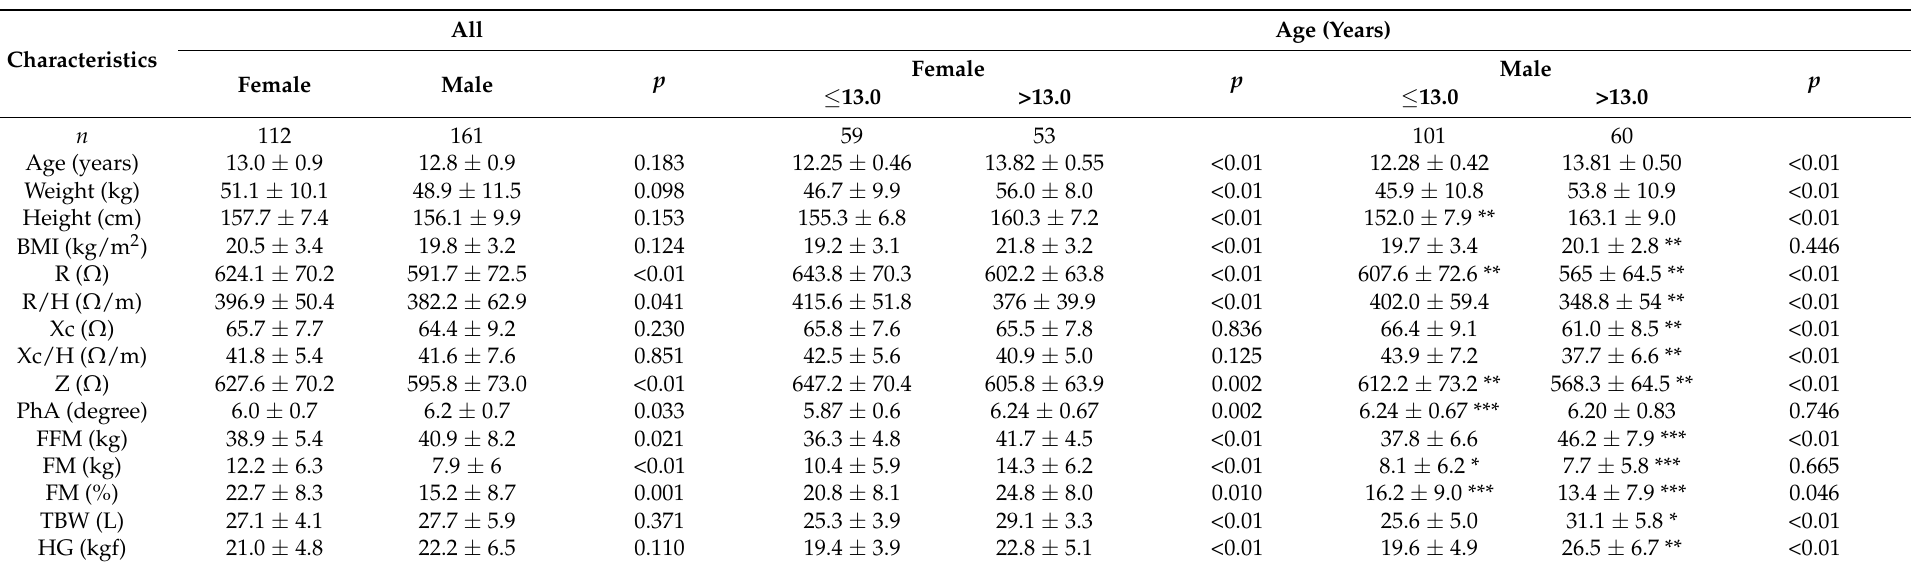
Table 2. Descriptive and comparative general characteristics, according to sex and age categories ( n =